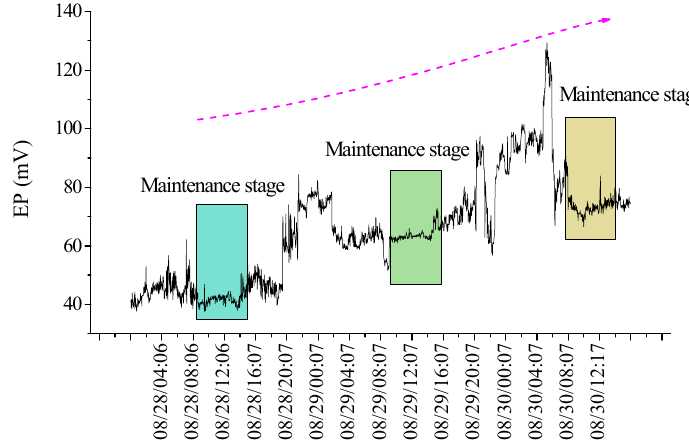
Figure 12. Influence on EP response during mining activities by maintenance.